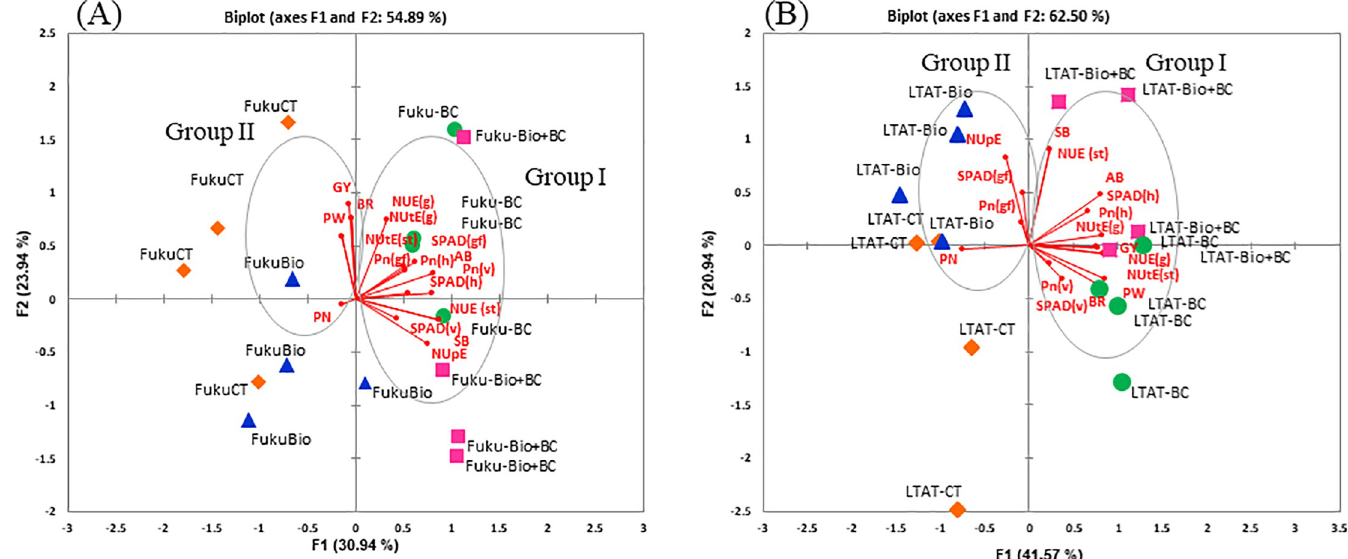
Fig 3. Principal component analysis (PCA) of yield and its related traits of different treatments (A) for Fukuhibiki and (B) for LTAT-29. (n = 4). Note: PN: panicle number, PW: panicle weight, SB: straw biomass, AB: above-ground biomass: GY: grain yield, BR: brown rice, NUE (g) or NUE (st): NUE in grain and straw, NUtE (g) or NUtE (st): NUtE in grain and straw, SPAD and P (v) (h) (gf): SPAD and Pn at vegetative, heading and grain filling stage, respectively. Rhombus filled with orange, triangle filled with blue, circle filled with green and square filled with pink represent the treatments of CT (control), Bio (biofertilizer), BC (biochar) and biofertilizer + biochar,